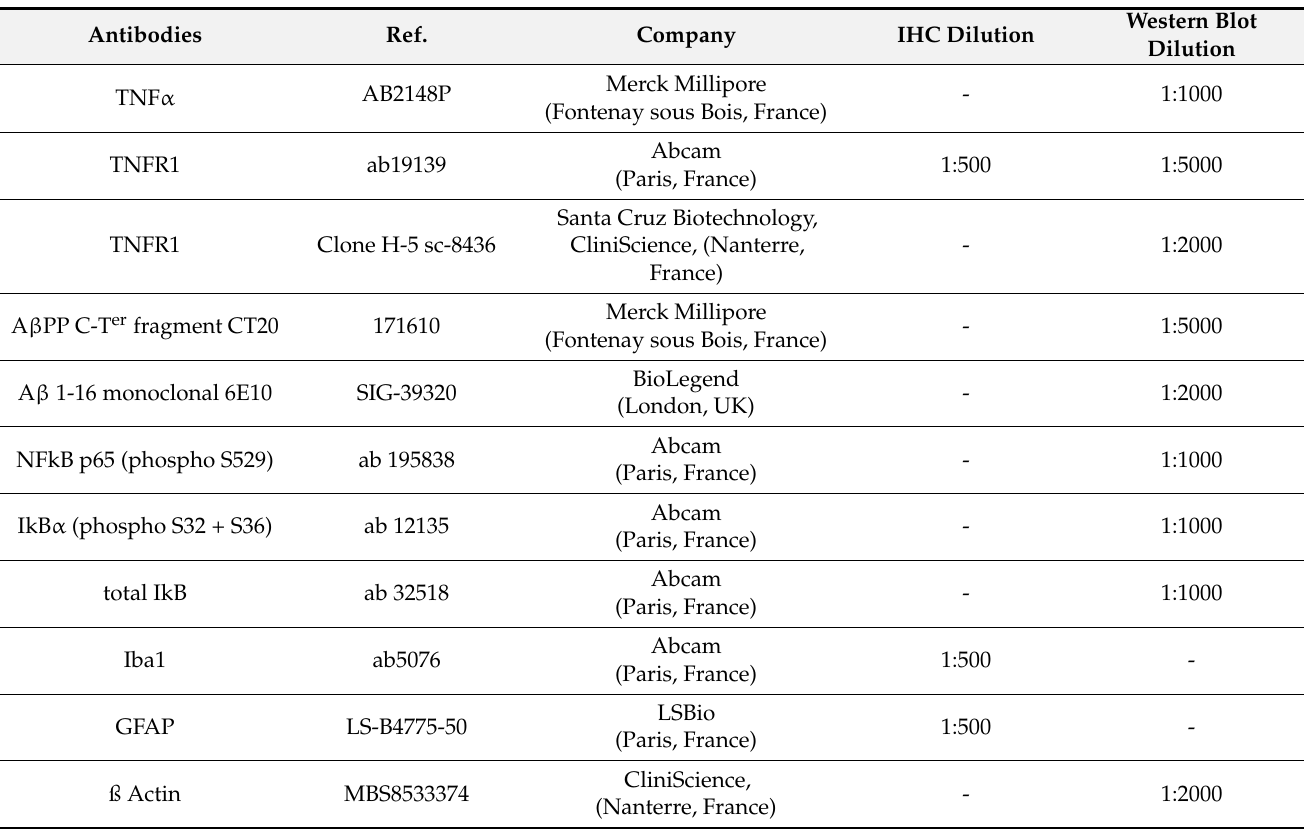
Table 1. List of antibodies used to IHC and Western blot